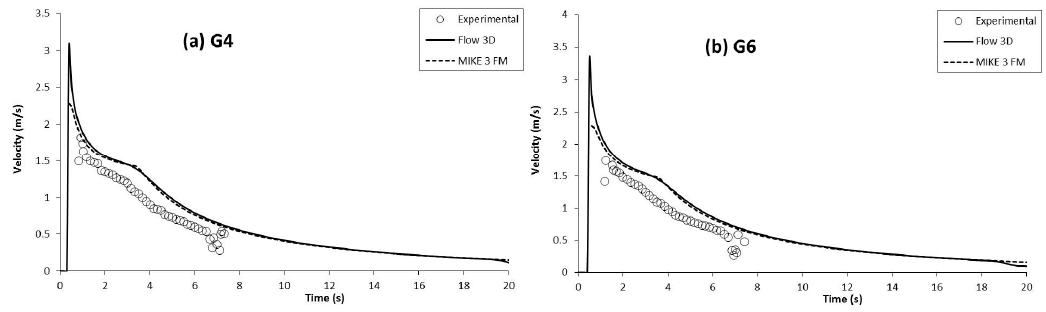
Table 4. RMSE values for the averaged velocity evolution at G4 and G6 based on experimental data by Khankandi et al. [39].